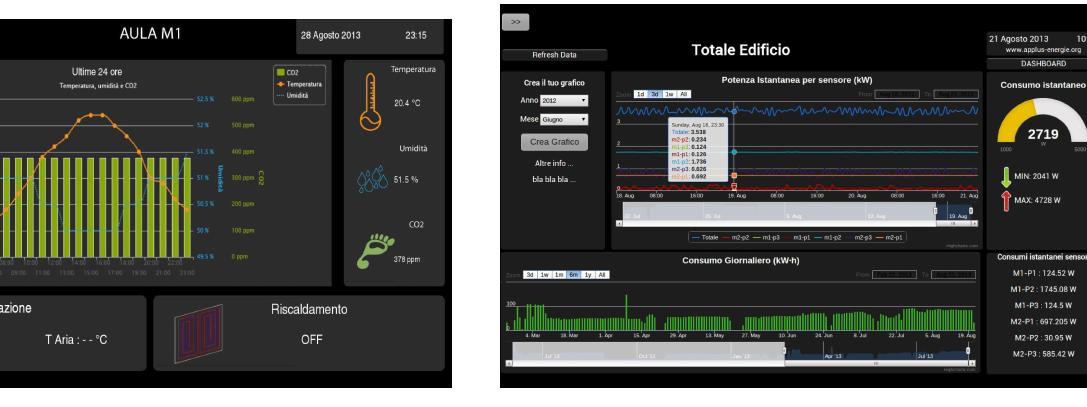
Figure 11. Example monitoring